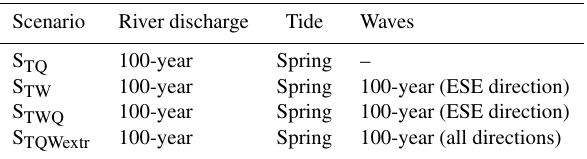
Table 3. Scenario